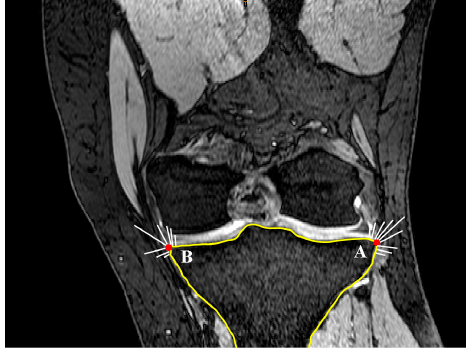
Figure 8. Location of nodes A and B based on Gaussian curvature analysis (coronal view).